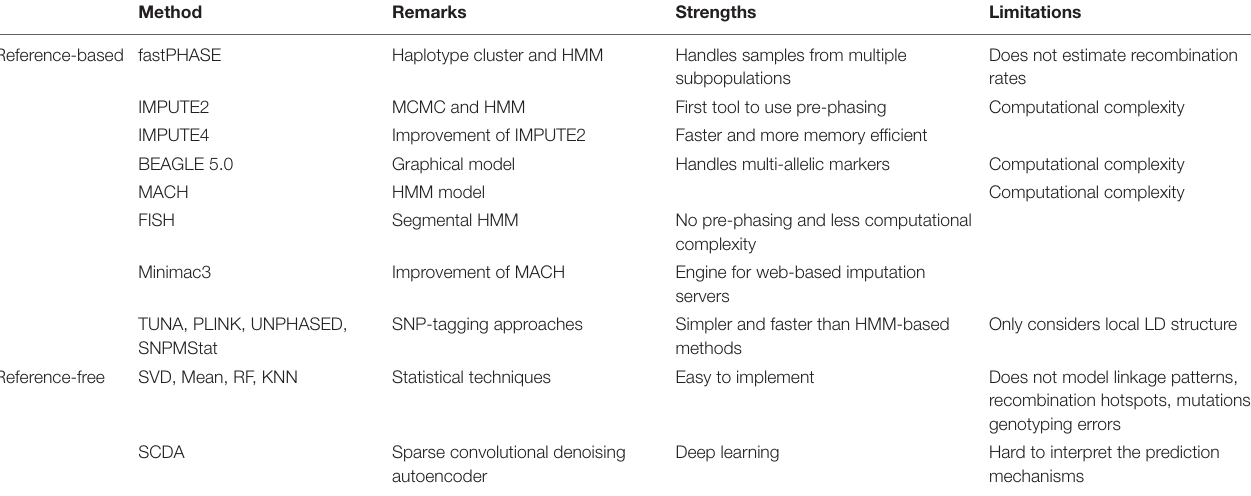
TABLE 1 | Genotype imputation